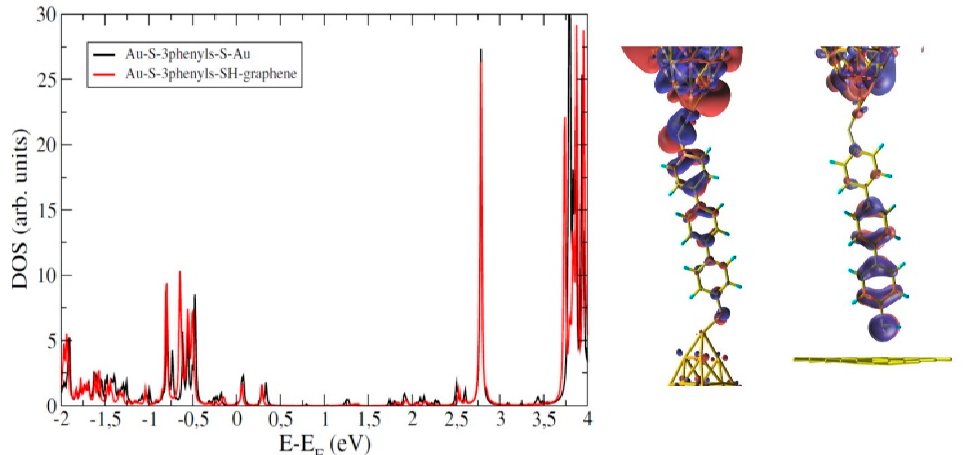
Figure 8. ( Left ) DFT calculated projected density of states for Au–graphene and Au–Au triphenyl molecular junctions using thiol groups. ( Right ) Representation of the corresponding HOMO wavefunction for both junctions. Reprinted figure from [50] and with permission. Copyright (2019) American Chemical Society.